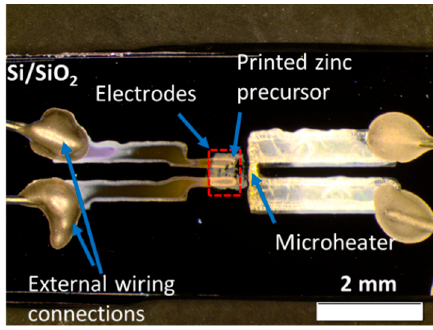
Figure 2. Optical image of the printed Joule heating device showing the three main components of the device, such as electrodes section, printed zinc salt film, and micro-heater. The picture was taken after the heat treatment of the ZnO pattern.